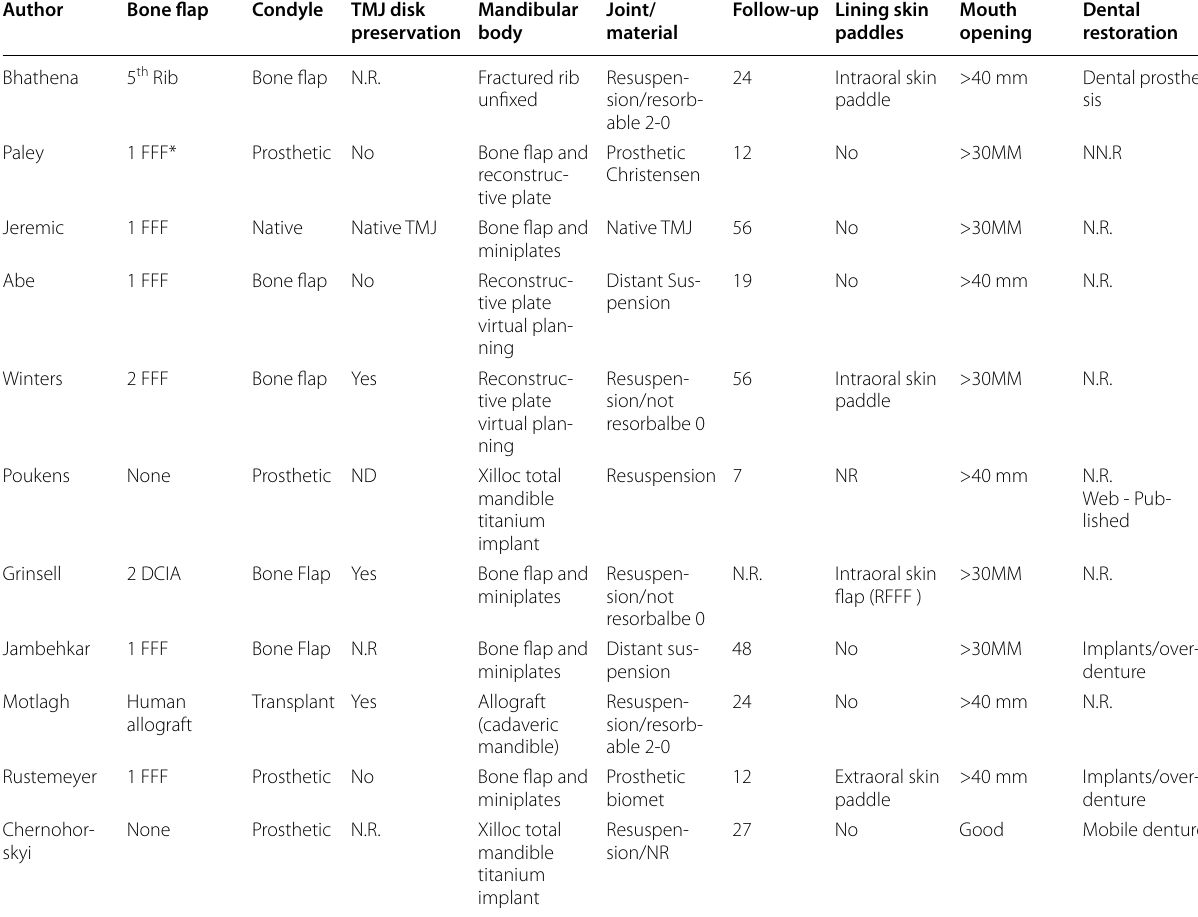
Table 2 Comparison of the different surgical solutions (see Table 1) used for bicondylar mandibular reconstructions: articular disk preservation, condylar resuspension to the glenoid fossa, soft tissue flaps or paddles for intra- or extraoral lining, functional outcomes, and dental